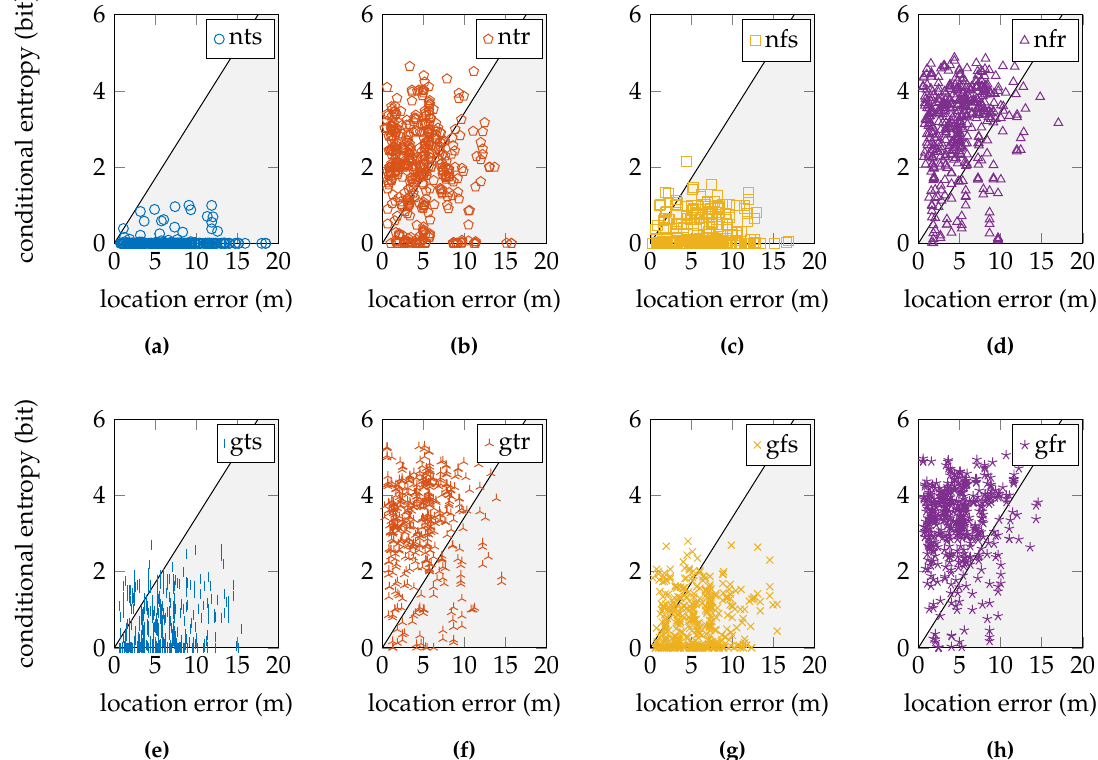
Figure 11. The relation tested on the GEOTEC dataset. The legend labels refer to using the normal sensor model (n) or using the convolution sensor model (g), using the trained σ (t) or using the fixed σ (f) and using a single reference location for training (s) or using a region of reference locations for training